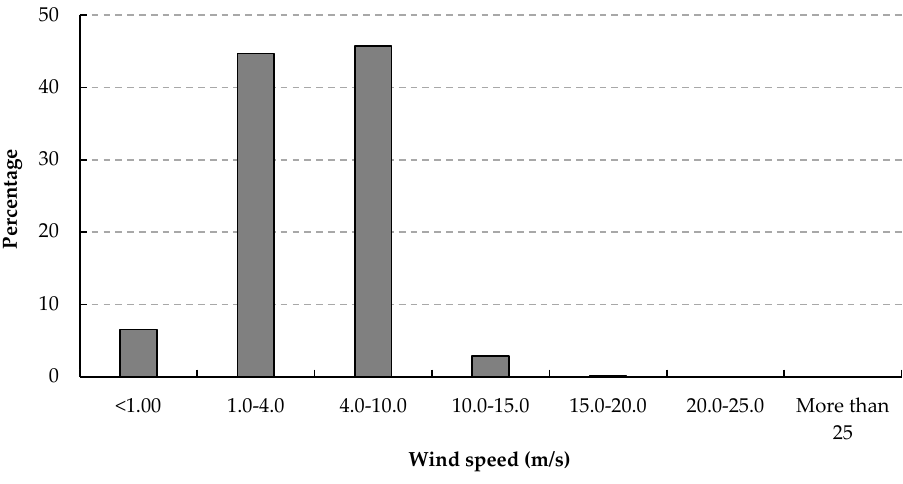
Figure 8. Wind class frequency distribution of Siri Island